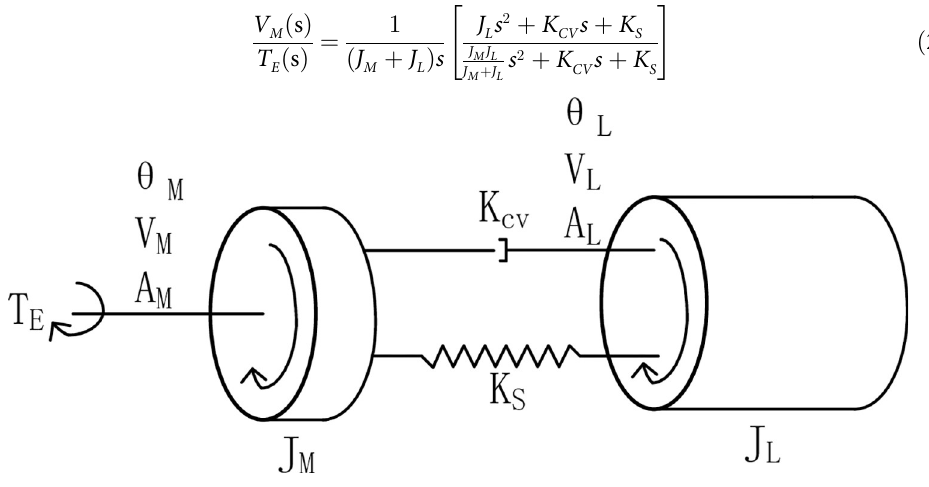
Fig 2. Servo system two-mass